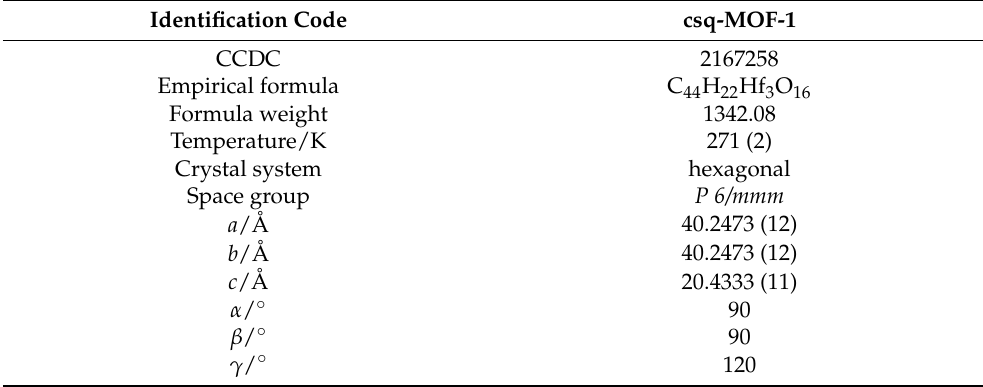
Table 1. Crystal data and structure refinement for